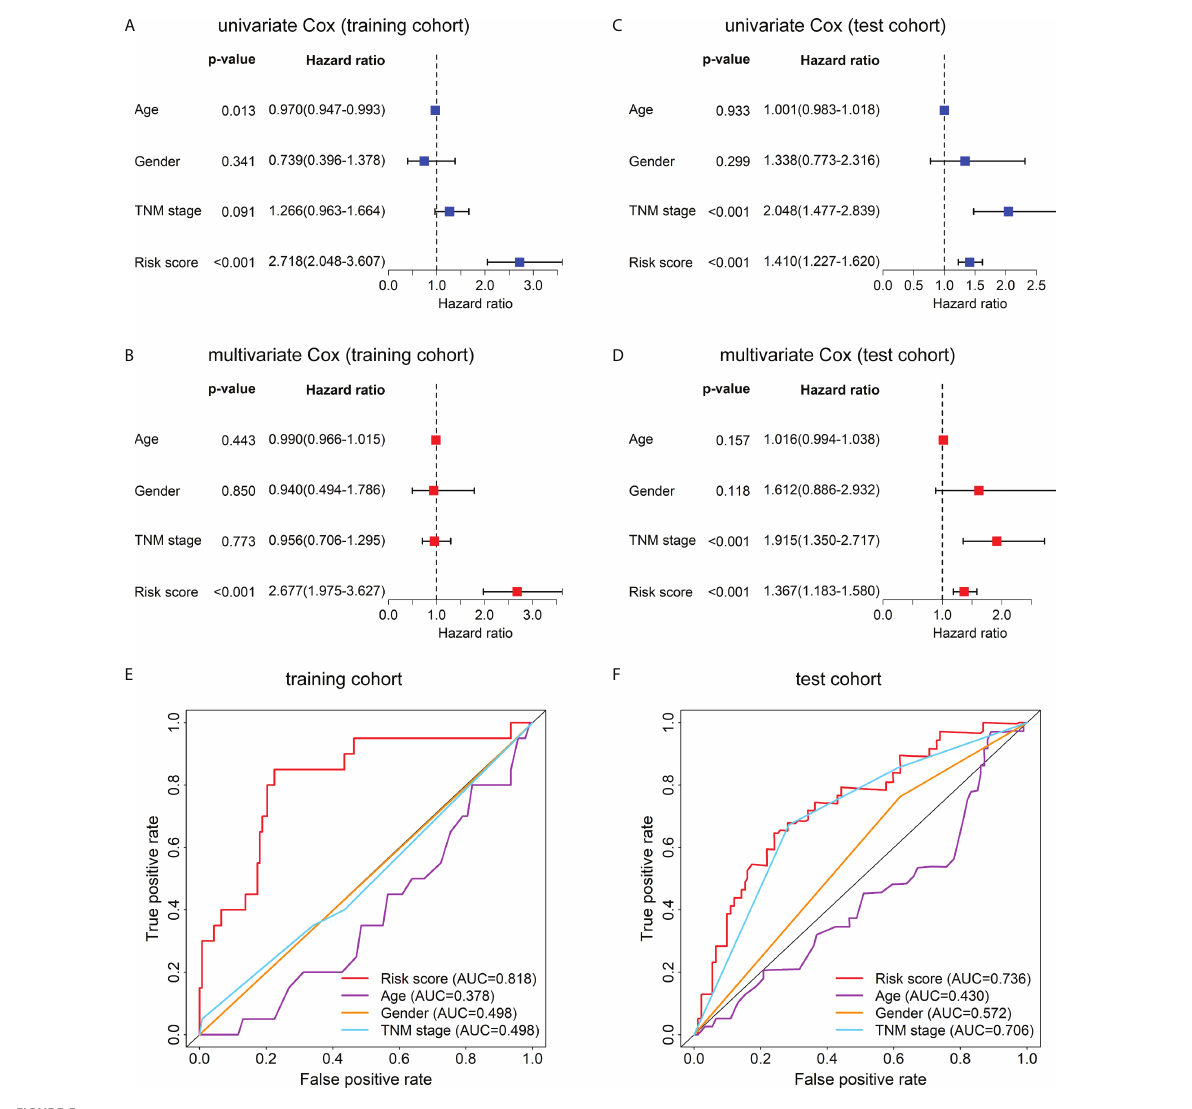
FIGURE 5 Univariate Cox, multivariate Cox, and ROC curve analyses of the risk score and clinical characteristics in the training and test cohorts. Forest plots of the univariate (A) and multivariate (B) Cox regression analyses of risk score and clinical characteristics in the training cohort. Forest plots of the univariate (C) and multivariate (D) Cox regression analyses of the risk score and clinical characteristics in the test cohort. (E) The ROC curves at 1-year OS of the risk score and clinical characteristics in the training cohort. (F) The ROC curves at 1-year OS of the risk score and clinical characteristics in the test